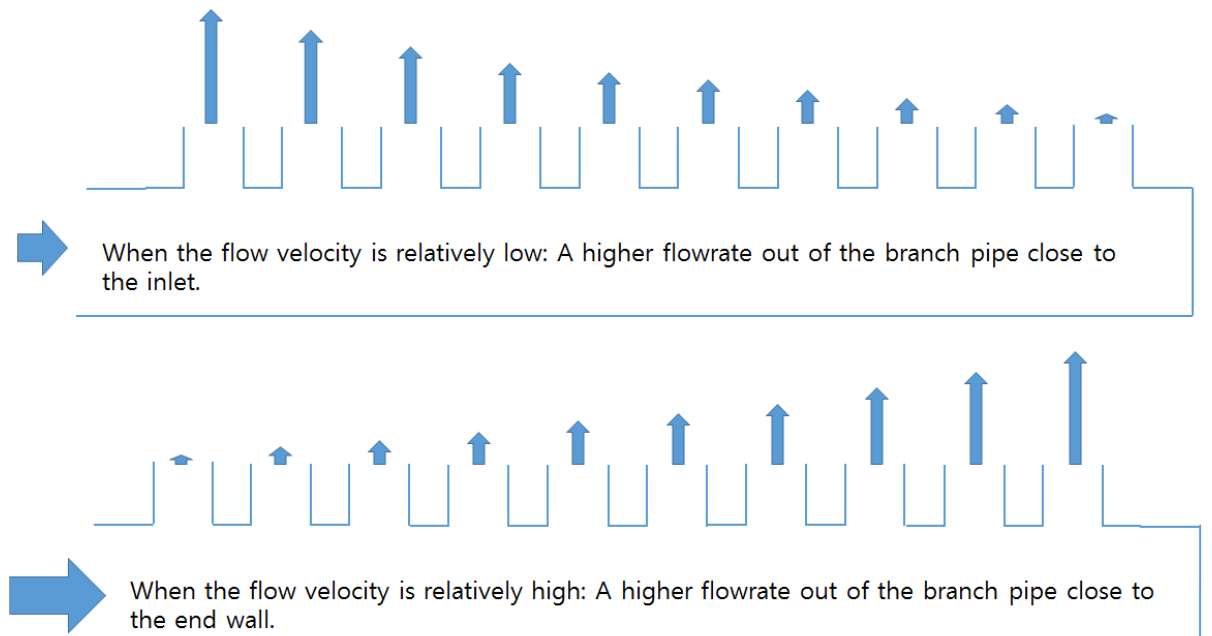
Figure 10. Relationship between header pipe inlet velocity and flow distribution pattern.